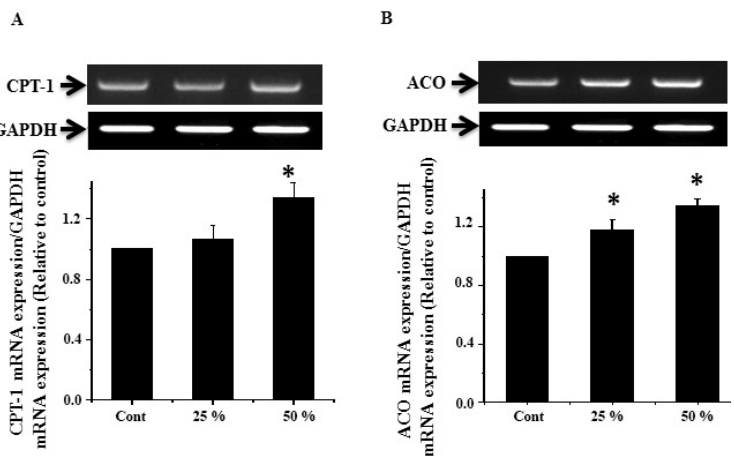
Figure 5. Effect of ginger water on GLUT-2 ( A ) and PK ( B ) mRNA expressions in the hepatic tissue of rats. Results of densitometric analyses and demonstrative blots of at least five independent experiments are displayed. Values are expressed as means ± SE. Cont: control, 25%:25% ( v / v ) ginger water-treated group, 50%:50% ( v / v ) ginger water-treated group. * p < 0.05 vs. the control.